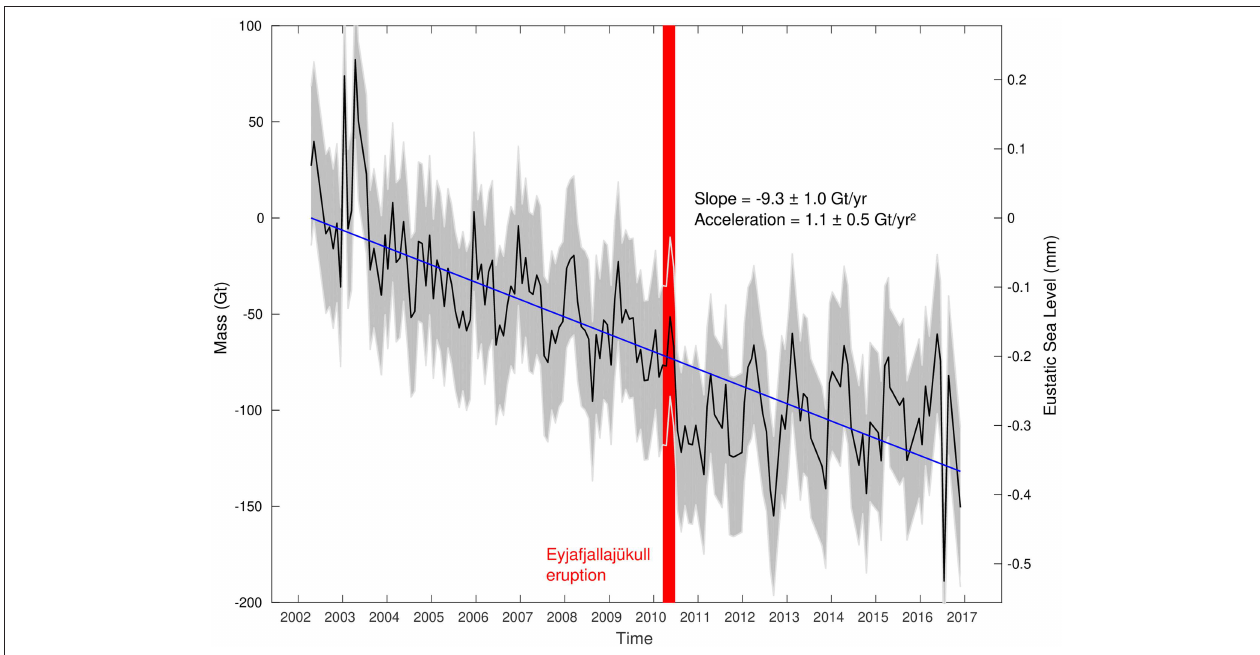
FIGURE 3 | GRACE-derived mass loss trend over Iceland. The black line indicates the total integrated monthly mass change since 2002 (gigatons left axis and equivalent ecstatic sea level change, right axis), and the gray shaded region is its ± 2 σ uncertainty interval. The blue line is the best-fit linear equation over the entire timespan. The red strip highlights the time period of the Eyjafjallajükull volcanic